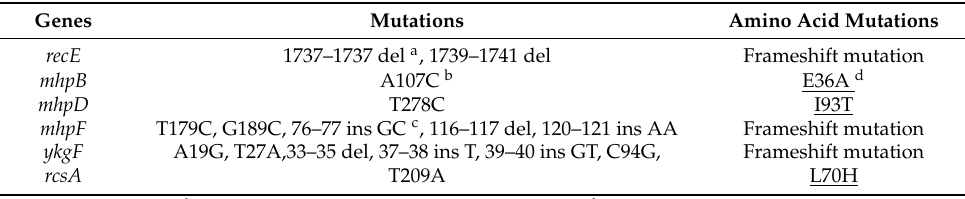
Table 2. The genetic mutation library of the adapted mutant